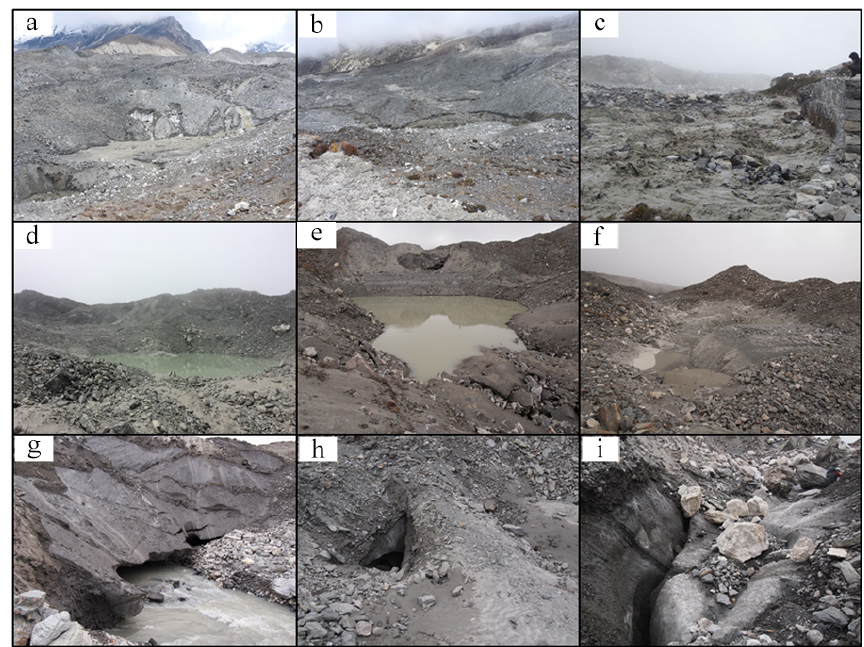
Figure 2. Key features of the glacier outburst flood from Lhotse Glacier: (a) subsurface and supraglacial flooding where the event was first observed; (b) main channels of flood path during the flood’s peak; (c) flood undercutting the gabions at Chukhung, at 14:19; (d) potentially drained pond with large bare ice faces behind it; (e) potentially drained pond with a collapsed englacial conduit behind it; (f) potentially drained pond with sinkholes; (g) meltwater exiting the glacier into the main channel via a large englacial conduit; (h) a vertical englacial conduit and sinkholes with wet, fine sediment indicating a drainage pathway; and (i) large vertical crevasses with clean ice likely from the supraglacial flood path.